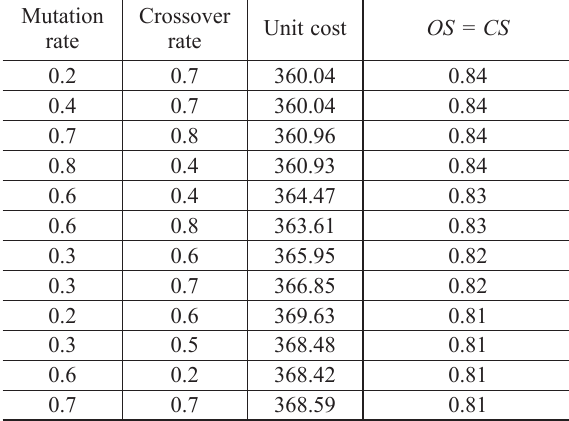
Table 2. Trade-offs corresponding to the parameters Mutation Crossover rate rate